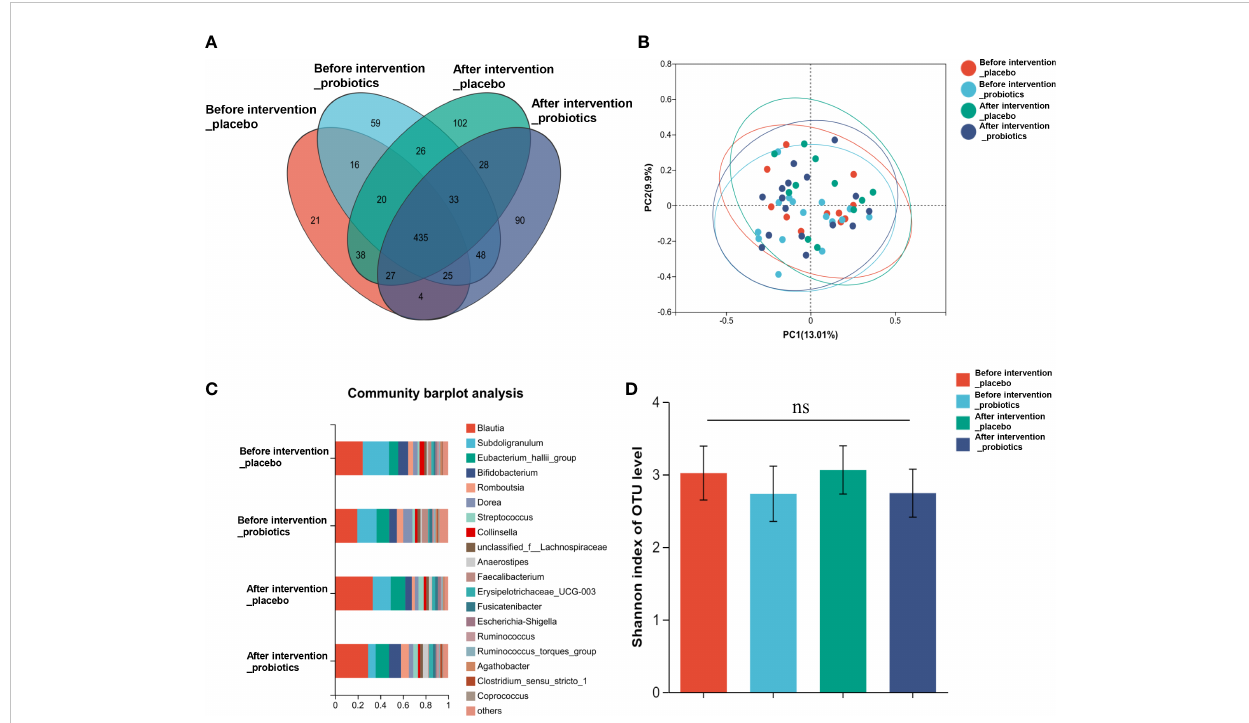
FIGURE 4 Composition and diversity of gut microbiota before and after two years probiotics or placebo intervention. (A) The Venn diagram shows the common or endemic species between groups in the level of OUT; (B) Weighted UniFrac PCoA; (C) Compositional change at the genus level; (D) a diversity analysis of gut